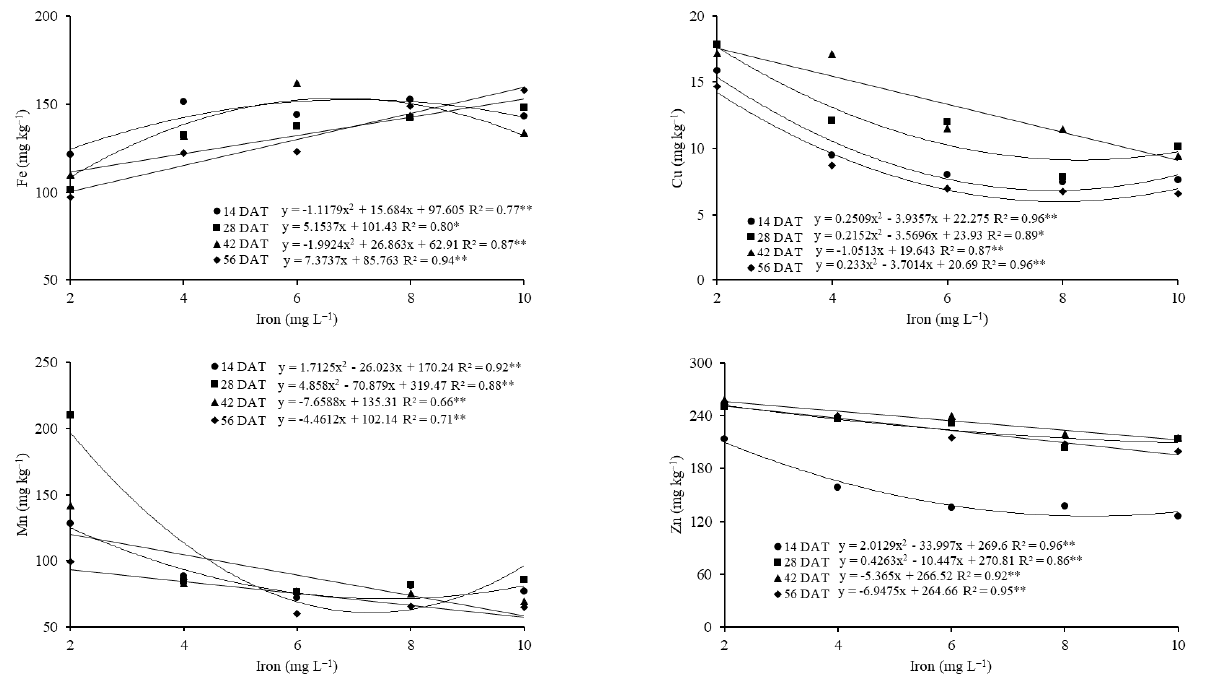
Figure 3. Foliar contents of iron (Fe), copper (Cu), manganese (Mn) and zinc (Zn) in collard greens as a function of iron concentration in the nutrient solution at 14, 28, 42 and 56 days after the application of treatments (DAT). Significant at * p ≤ 0.05 and ** p ≤ 0.01.